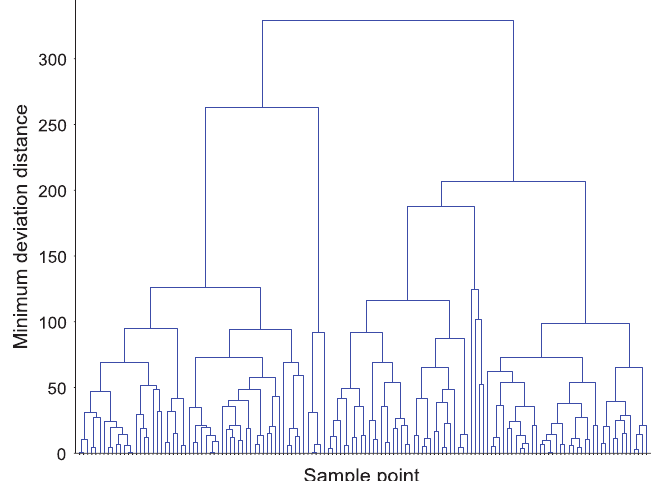
Figure 5: Flight Time Hierarchical Clustering Tree.